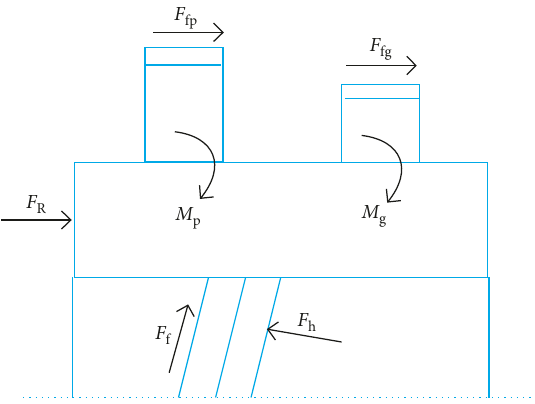
Figure 4: The forces acting on the sliding unit.